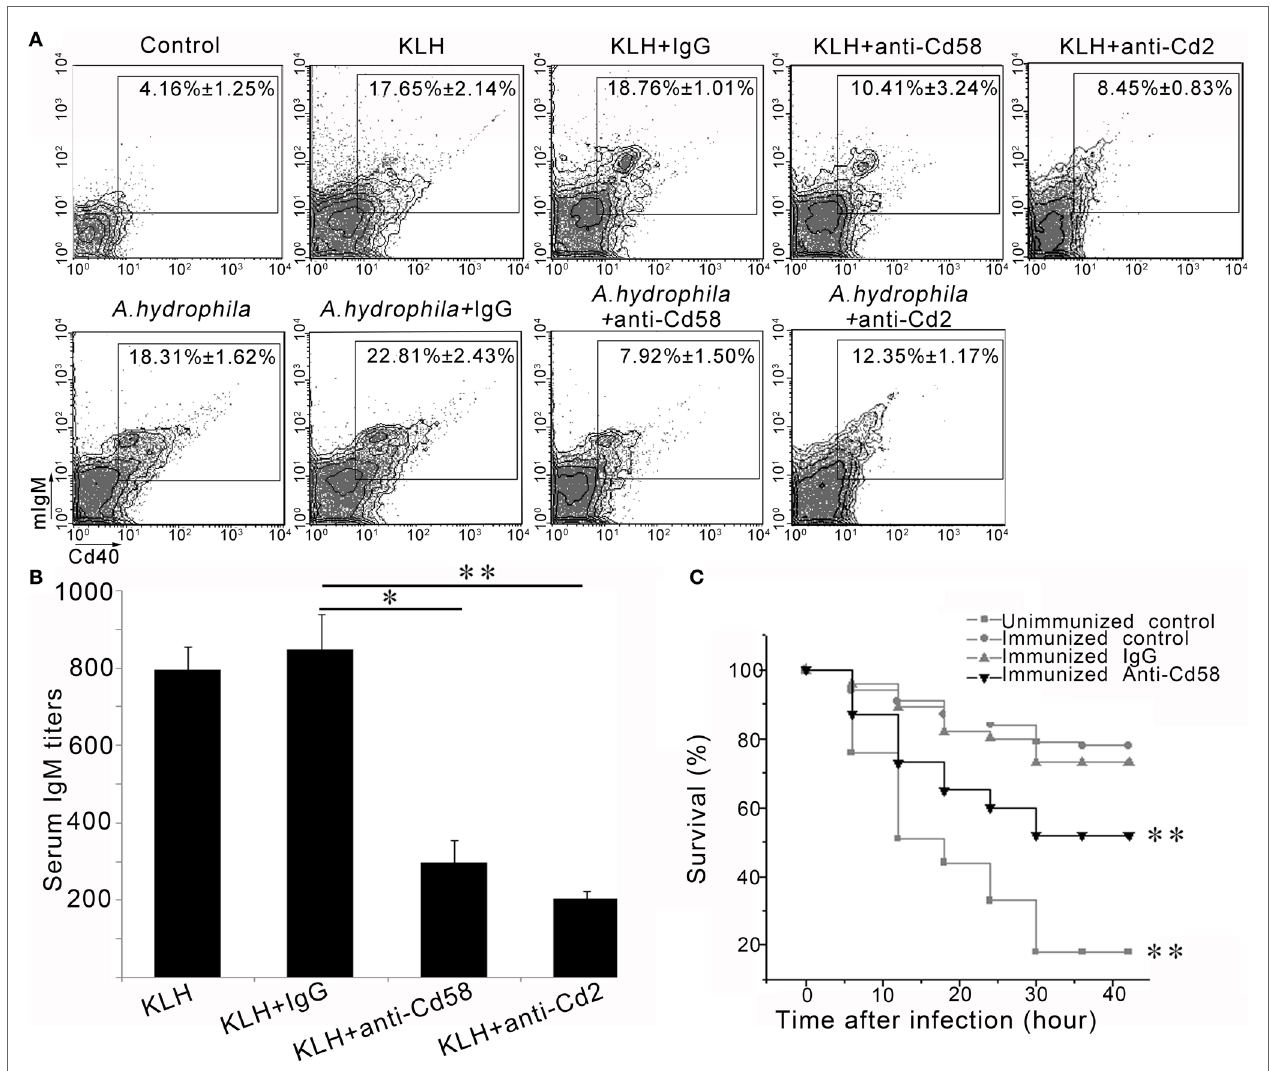
FigUre 9 | In vivo evaluation of Cd58 and Cd2 in B cell activation, antibody production and vaccinated immunoprotection. (a) Involvement of Cd58 and Cd2 in B cell activation. The degree of B cell activation is represented by the percentage of mIgM + Cd40 + cells determined by flow cytometry. The experimental treatments are presented at the top of each block diagram. The data above the outlined area in each block diagram indicate the average percentage of mIgM + Cd40 + B cells in each treatment group. (B) Involvement of Cd58 and Cd2 in IgM production. The titer of IgM against keyhole limpet hemocyanin (KLH) in each treatment group was examined by ELISA ( n = 150) (* p < 0.05, ** p < 0.01). (c) Blockade of Cd58 impairs the vaccinated immunoprotection against bacterial ( Aeromonas hydrophila ) challenge. Data points are from three independent experiments ( n = 30); Differences were analyzed using log-rank test (** p <